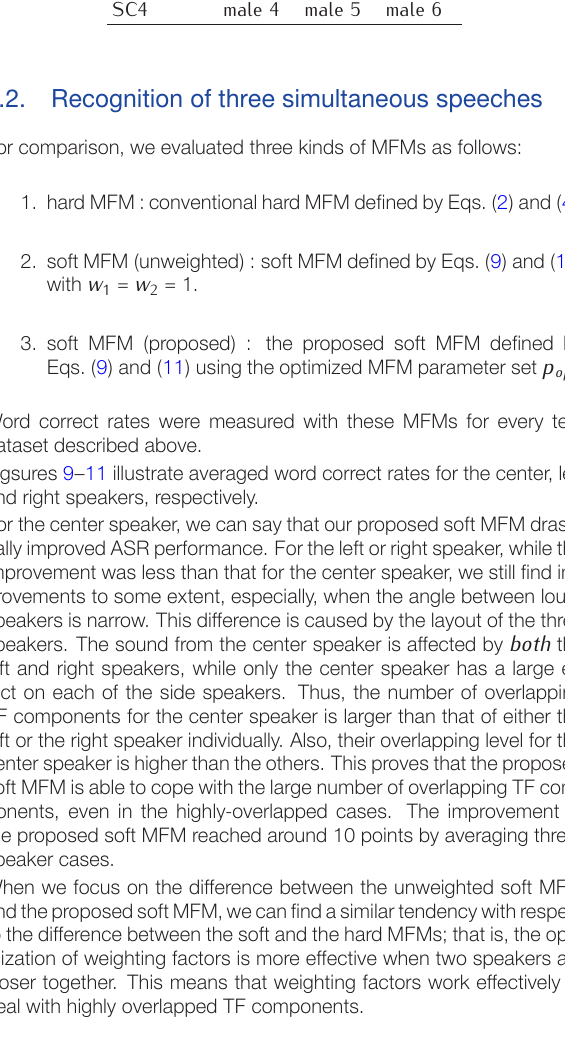
Figure 9. Word correct rate for the center speaker.